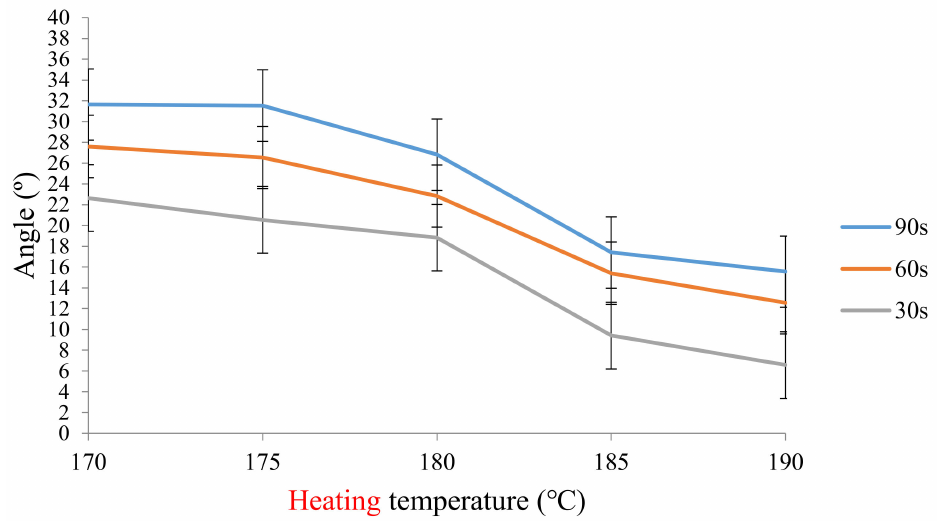
Figure 8. Recovery angle of the stimulus-responsive shape-memory composite material at various heating temperatures (with a heating time of 30, 60, and 90